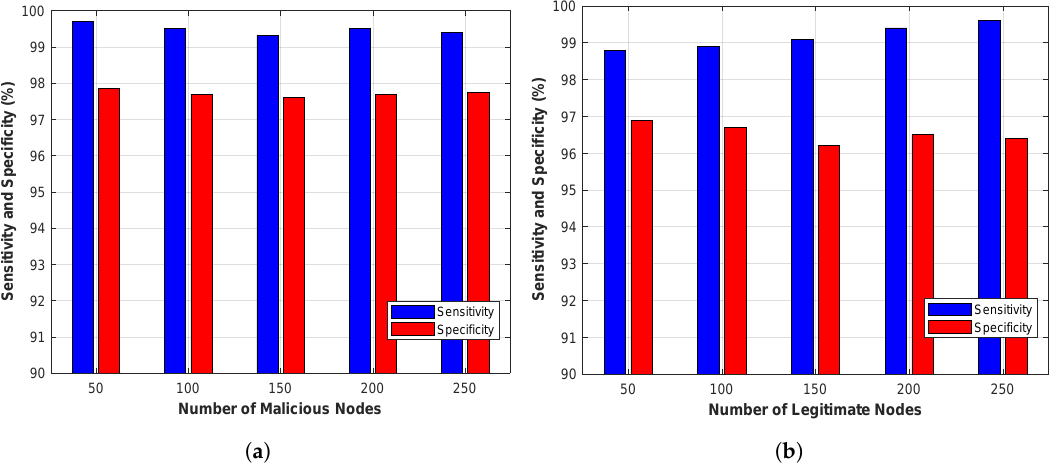
Figure 13. Sensitivity and specificity against ( a ) malicious nodes and ( b ) legitimate